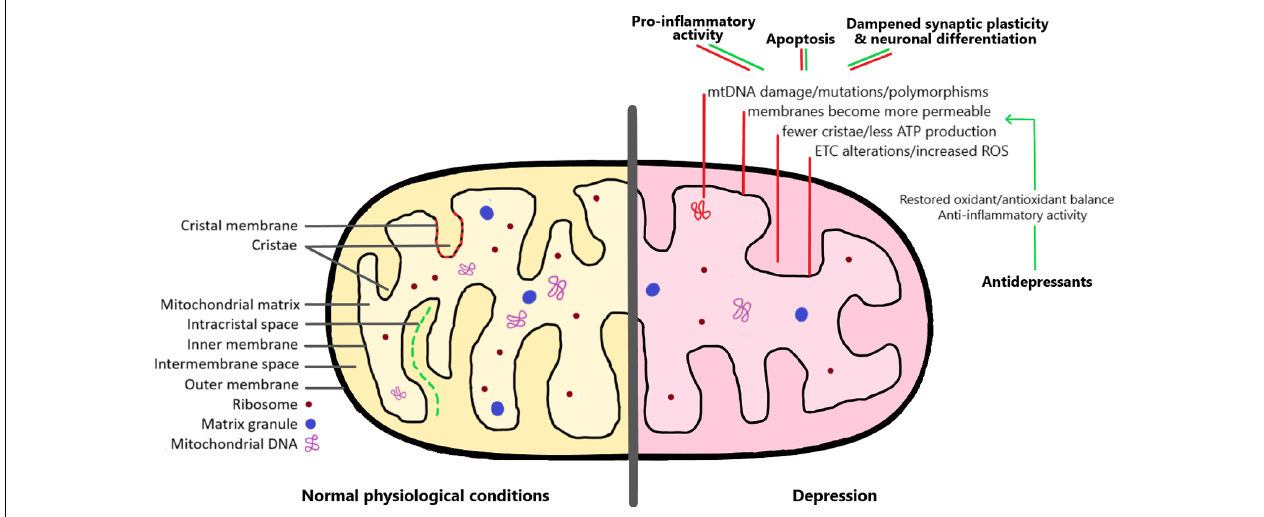
FIGURE 1 | The mitochondrion under normal physiological conditions and in the depression brain. As detailed in the right side of the image, there are a series of mitochondrial alterations that have been observed both in depressed patients and in animal models of depression (red lines). These include changes affecting mitochondrial DNA, membrane permeability, and increased formation of reactive oxygen species (ROS). As a consequence, these alterations lead to pro-inflammatory activity, increased apoptosis, and dampened synaptic plasticity and neuronal differentiation. Interestingly, antidepressant medication can restore the mitochondrial oxidant/antioxidant balance, and therefore help to rescue the negative effects of mitochondrial dysregulation (green lines). See the text for more detailed explanations.